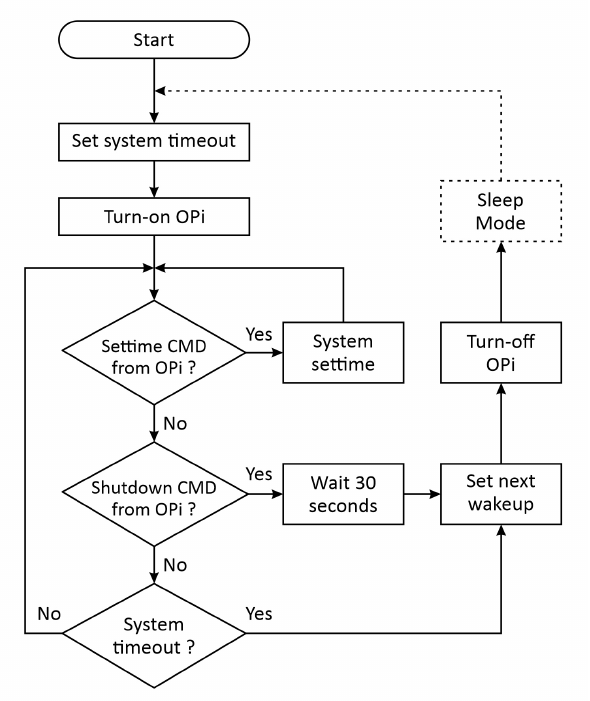
Figure 2. Shield microcontroller’s firmware